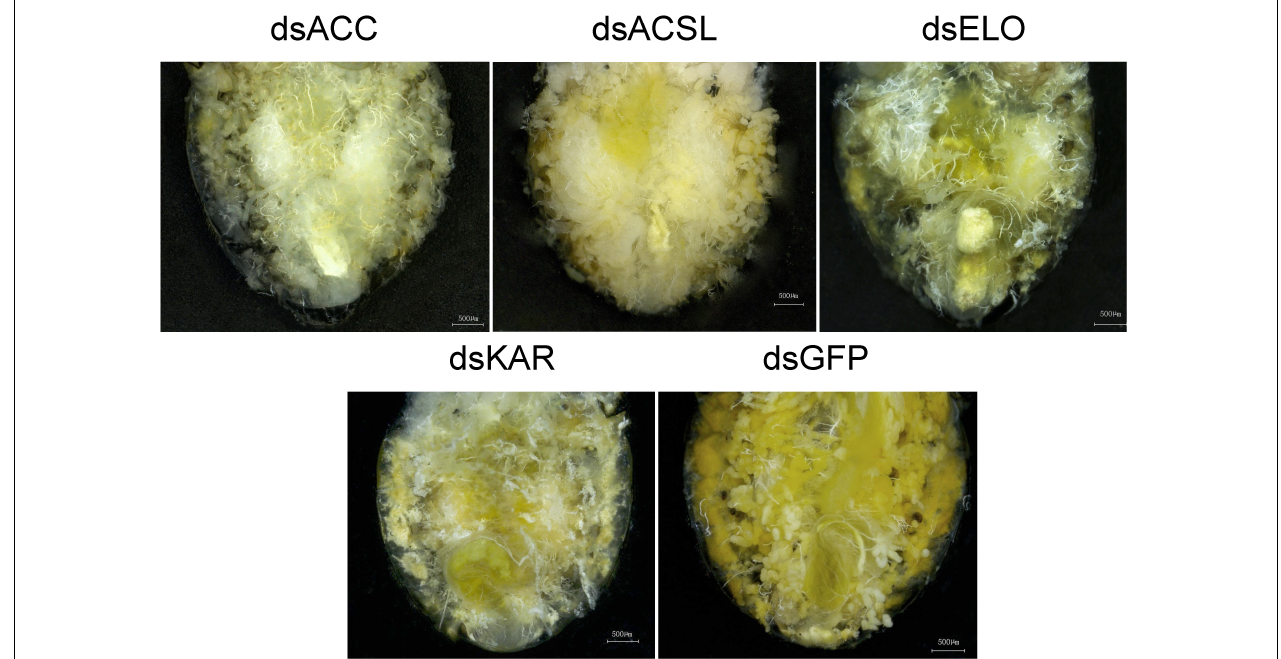
FIGURE 5 | dsACC, dsACSL, dsELO, dsKAR, and dsGFP were injected into the abdomen of a 7-day-old female Coccinella septempunctata after rearing for 2 days under diapause-induced conditions.